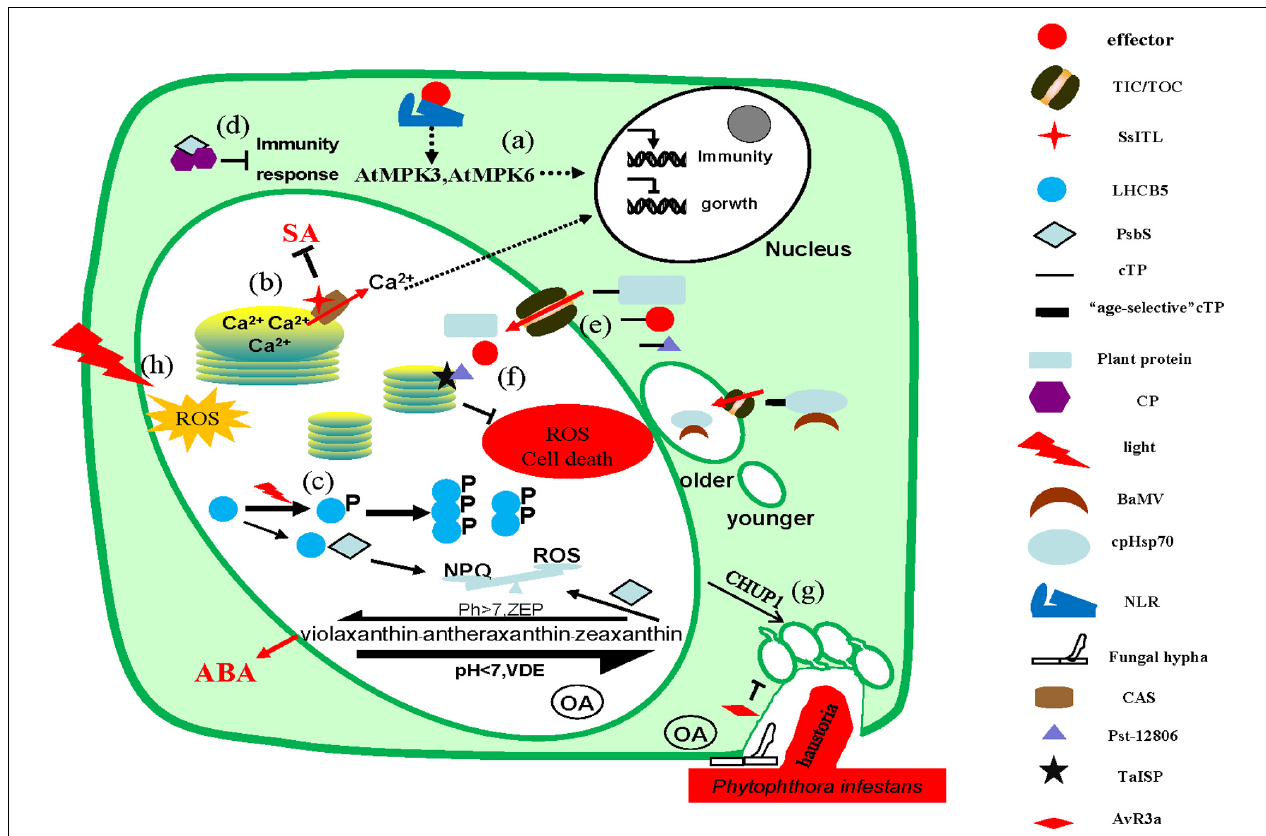
FIGURE 1 | Microbes interfere with chloroplast functions. (a) Activated nucleotide-binding leucine-rich repeat domain-containing receptors (NLRs) activate MPK3 and MPK6 through unknown mechanisms, regulating the immune responses by increasing the expression of immune-related genes. (b) Once pathogen-associated molecular pattern (PAMP)-triggered immune signals are transported to the chloroplast, Ca 2 + flows out from the thylakoid lumen to the stroma through the calcium-sensing (CAS) receptor, transmitting the signals to the nucleus via the retrograde signaling pathway, eliciting immune response. SsITL interacts with CAS to inhibit salicylic acid (SA) accumulation and promotes infection. (c) Phosphorylated LHCB5 exists as a dimer or trimer instead of a monomer, which weakens the interaction with PsbS and then weakens non-photochemical quenching (NPQ), promoting the production of reactive oxygen species (ROS). S. sclerotiorum secretes oxalate during infection to acidify the host tissue and accelerates the synthesis of zeaxanthin from violaxanthin, which reduced the production of ROS and ABA. (d) The CP protein of the virus interacts with PsbS as dimers in the cytoplasm to sequestrate PsbS from functioning. (e) Proteins enter the chloroplast by interacting with the translocator located in the inner membrane (TIC)/outer membrane (TOC) on the chloroplast membrane via chloroplast transit peptide (cTP). Moreover, the cTP of cpHsp70 protein is age selective and the Bamboo mosaic virus (BaMV) virus interacts with it to preferentially enter the mature chloroplasts for more energy. (f) Pst_12806 interacts with TaISP protein in chloroplasts to reduce ROS production and thus inhibit host cells death. (g) During the infection of P. infestans , CHUP1 anchors chloroplasts to the host–pathogen interface and restricts the entry of pathogen. Meanwhile, P. infestans secretes effector AVR3a to inhibit the formation of chloroplast stromules to reduce the contact area. (h) The production of ROS in chloroplast increases under light conditions.